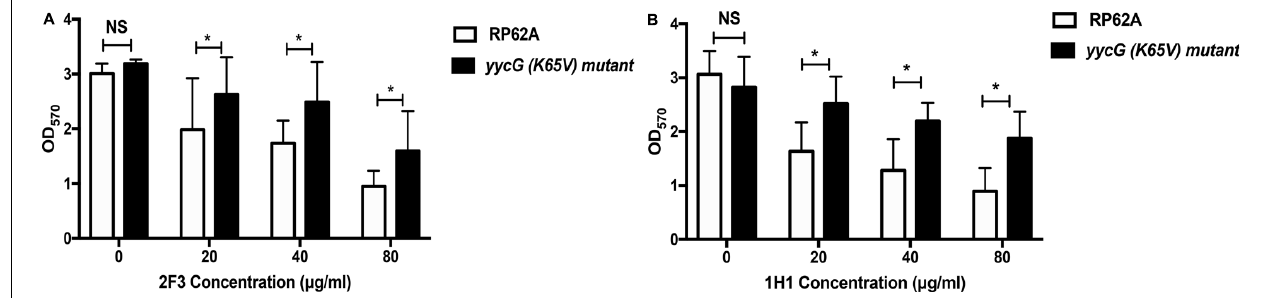
FIGURE 6 | Effect of YycG ex mAbs on biofilm formation of the yycG (K65V) mutant. Inhibition of biofilm formation by YycG ex mAbs was detected using a semiquantitative plate assay. Overnight cultures were diluted in fresh TSB containing twofold serial dilutions of YycG ex mAbs (80–20 µ g/mL) and incubated at 37 ◦ C for 24 h. Biofilms were stained with 2% crystal violet, and OD 570 was measured. Effect of mAb 2F3 (A) and mAb 1H1 (B) on the biofilm formation of the yycG (K65V) mutant and S. epidermidis RP62A. Experiments were performed using three replicates and repeated thrice independently. Statistical analysis was performed using Student’s t -test. * P < 0.05; NS, not